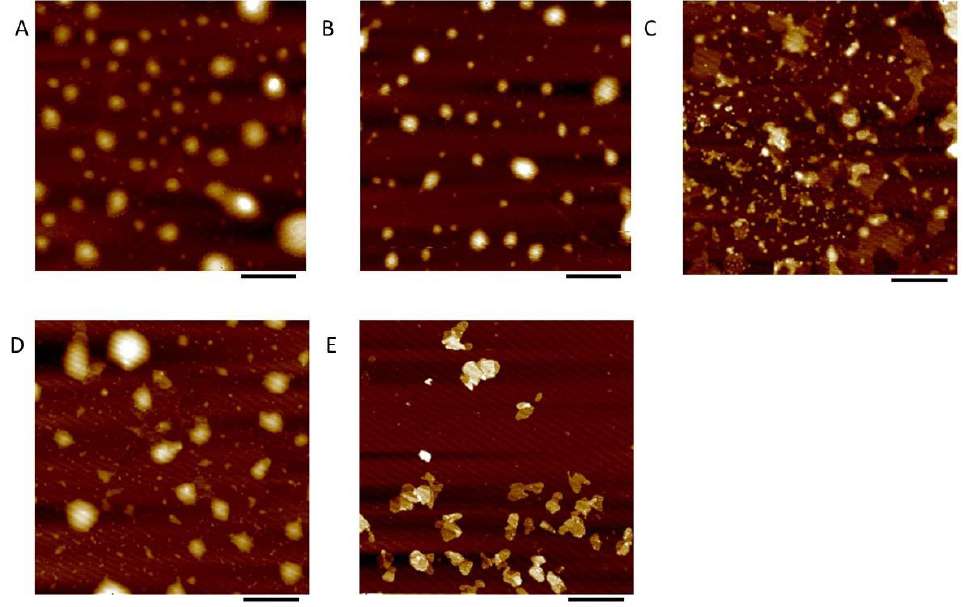
Figure 2. Atomic force microscopy (AFM) images of cinnamaldehyde-loaded liposomes (( A – E ): The inulin concentrations were 0%, 0.75%, 1.5%, 3% and 6%, w / w , respectively). The scale bars in the figure represent 1 μm